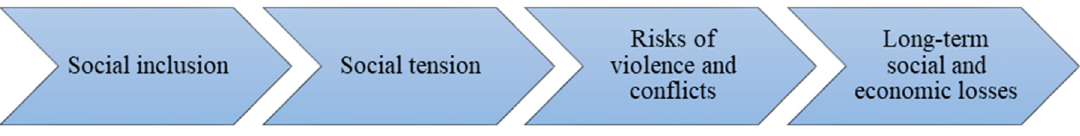
Figure 1. Key features of social sustainability and social inclusion .